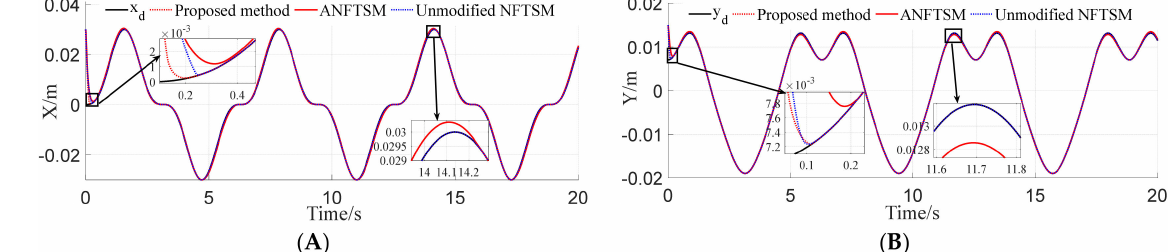
Figure 7. Position tracking. ( A ) X-direction, ( B ) Y-direction.